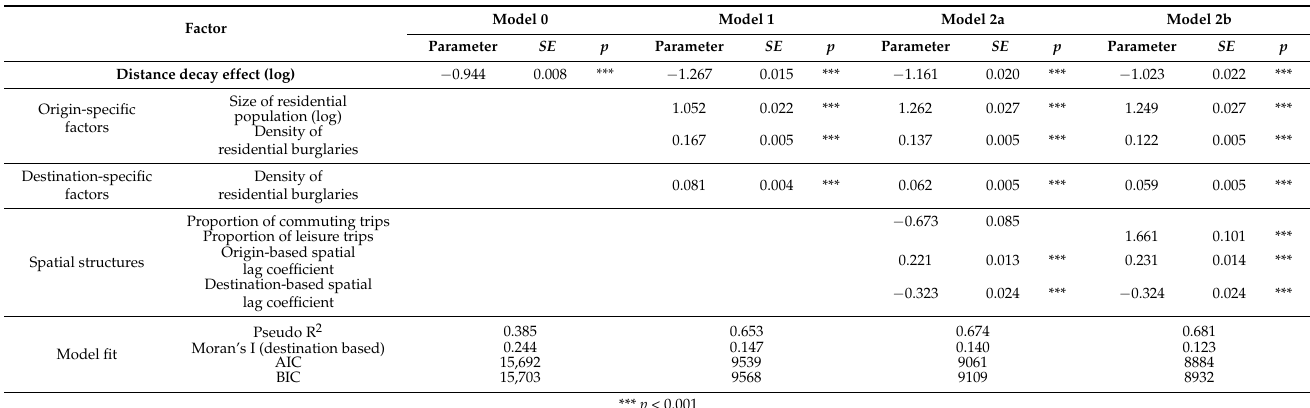
Table 2. Results of